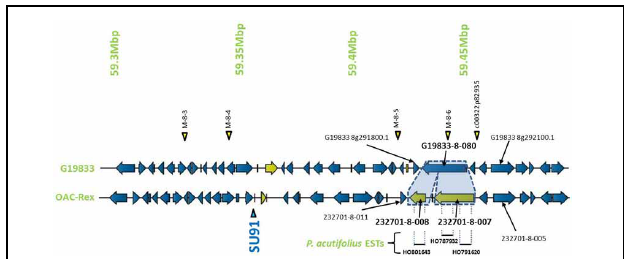
FIGURE 5 | Comparison of the regions surrounding the SU91 marker in OAC-Rex contig 232701 with the corresponding sequence from G19833 chromosome 8. Unique genes are marked in yellow, and the two genes (232701-8-007 and 232701-8-008) that are homologous with the G19833 Niemann Pick transporter gene are highlighted for comparison. 232701-8-007 has homology with two P. acutifolius ESTs (HO787932 and HO791620) while 232701-8-008, has homology to a single P. acutifolius (EST, HO801643). Highly conserved genes bordering this region in G19833 and OAC-Rex are labeled. The location of molecular markers are indicated with triangles above and below the